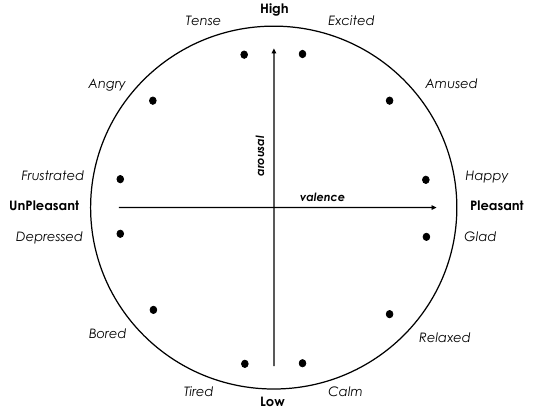
Figure 2. Examples of emotional states in the circumplex model. In this study, these states are divided into four groups: Pleasant-high, Pleasant-low, Unpleasant-high, and